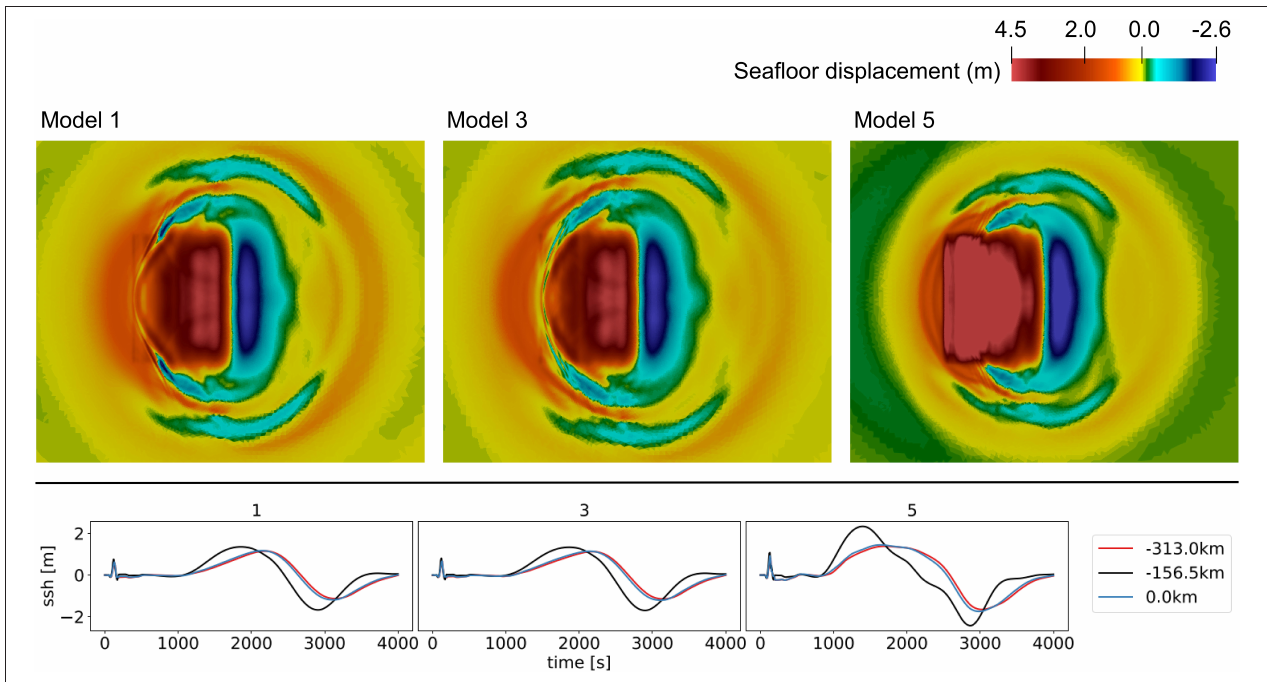
FIGURE 12 | (Top) Unfiltered seafloor displacements from dynamic rupture model 1B (supershear rupture in downdip direction), 3B (supershear rupture in updip direction), and 5 (tsunami earthquake) at a simulation time of 100 s. (Bottom) Tsunami generation sea surface height timeseries for model 1B, 3B, and 5 at x = − 100 km, y = − 150